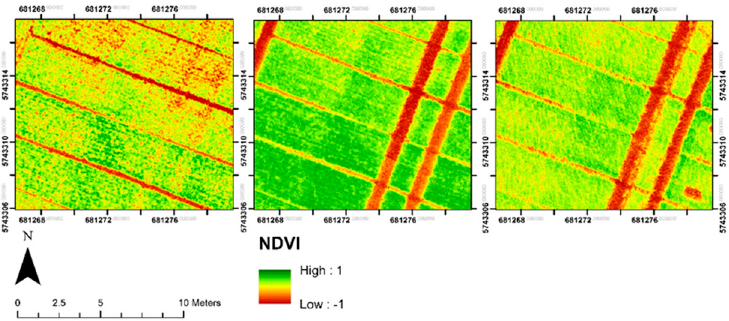
Figure 17. Example subset of NDVI orthomosaics from three dates—27 March 2017 ( left ), 18 May 2017 ( middle ), 21 June 2017 ( right ). Orthomosaics highlight the spatial variability of NDVI both between and within plots.